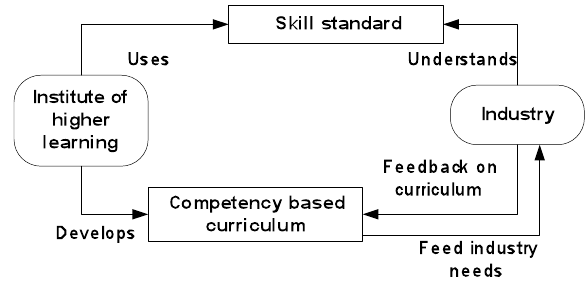
Figure 2. IHL-industry collaboration